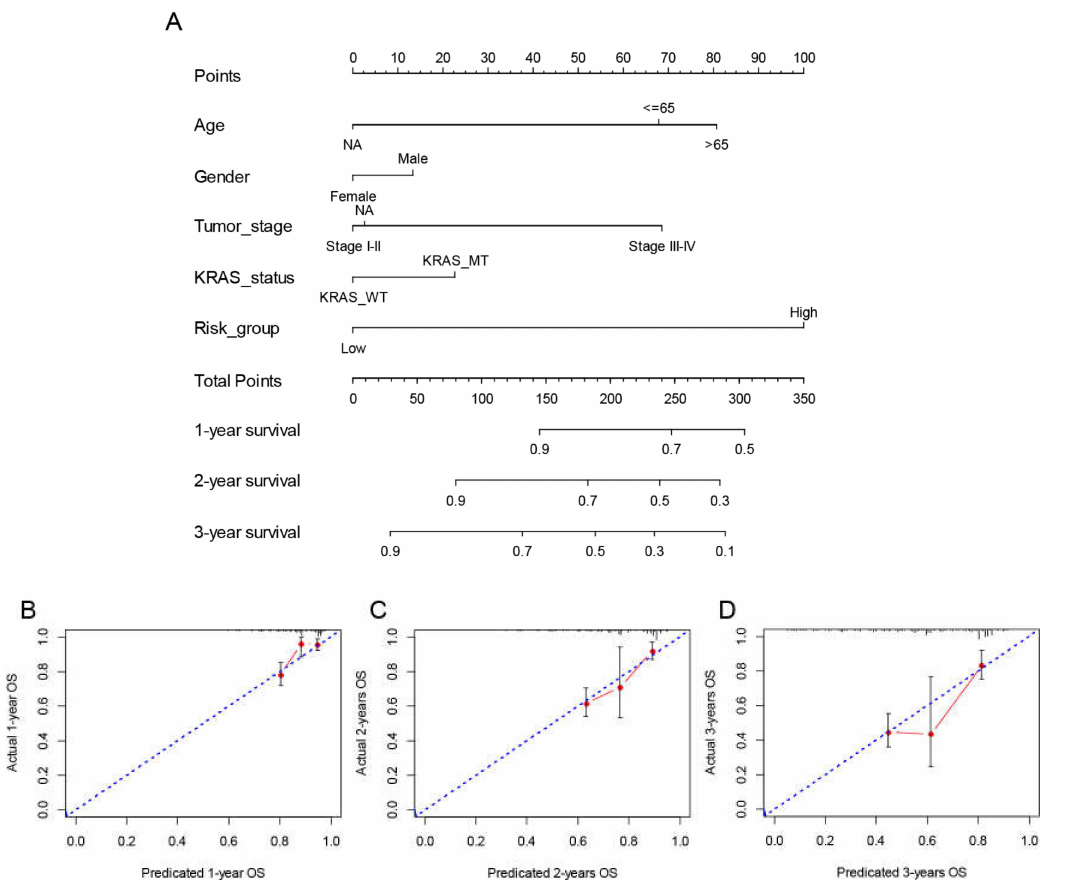
Figure 11. Construction and validation of the nomogram to predict OS in the TCGA LUAD co- hort. ( A ) The multivariate Cox model-based nomogram of LUAD patients in TCGA training group. ( B – D ) the calibration plots for the internal validation of nomogram, the x-axis represents the nomo- gram predicted OS and the y-axis represents the actual OS of patients with